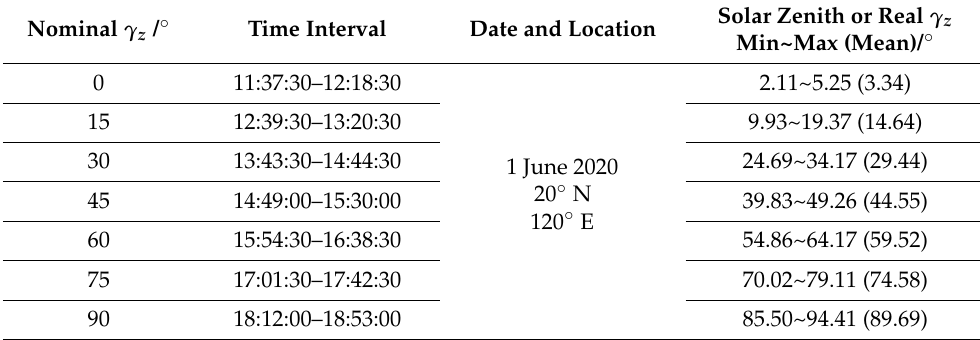
Table 4. Simulation assumptions for evaluating yaw estimation.